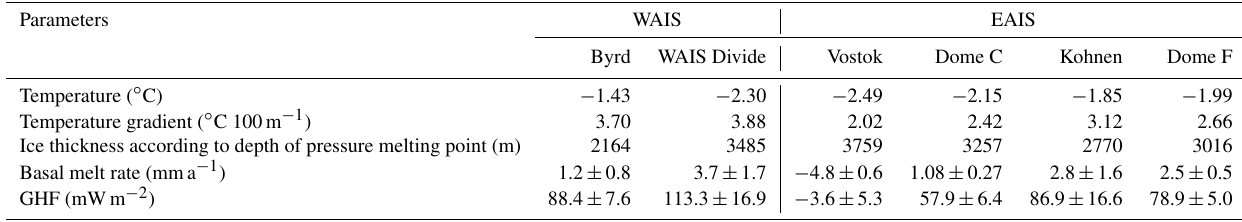
Table 2. Thermophysical properties at the base of the Antarctic Ice Sheet at sites of deep ice drilling estimated in this study. Parameters